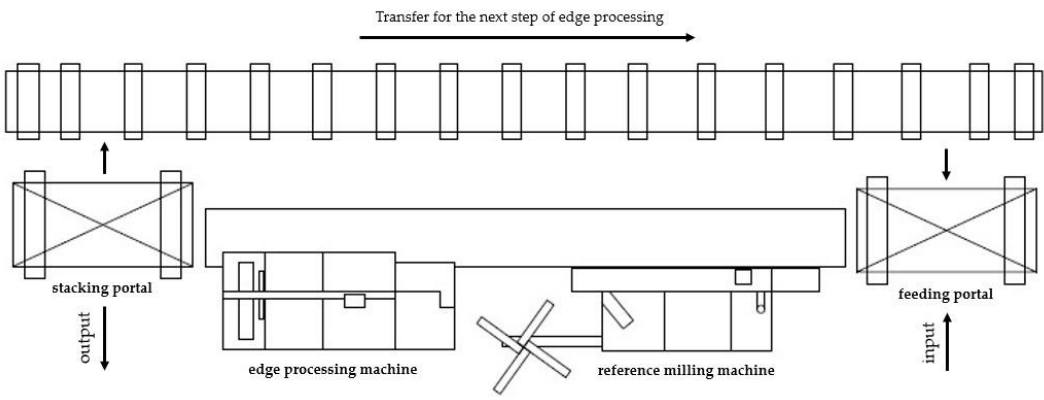
Figure 1. The arrangement diagram and the most important machine units of the edge banding module.